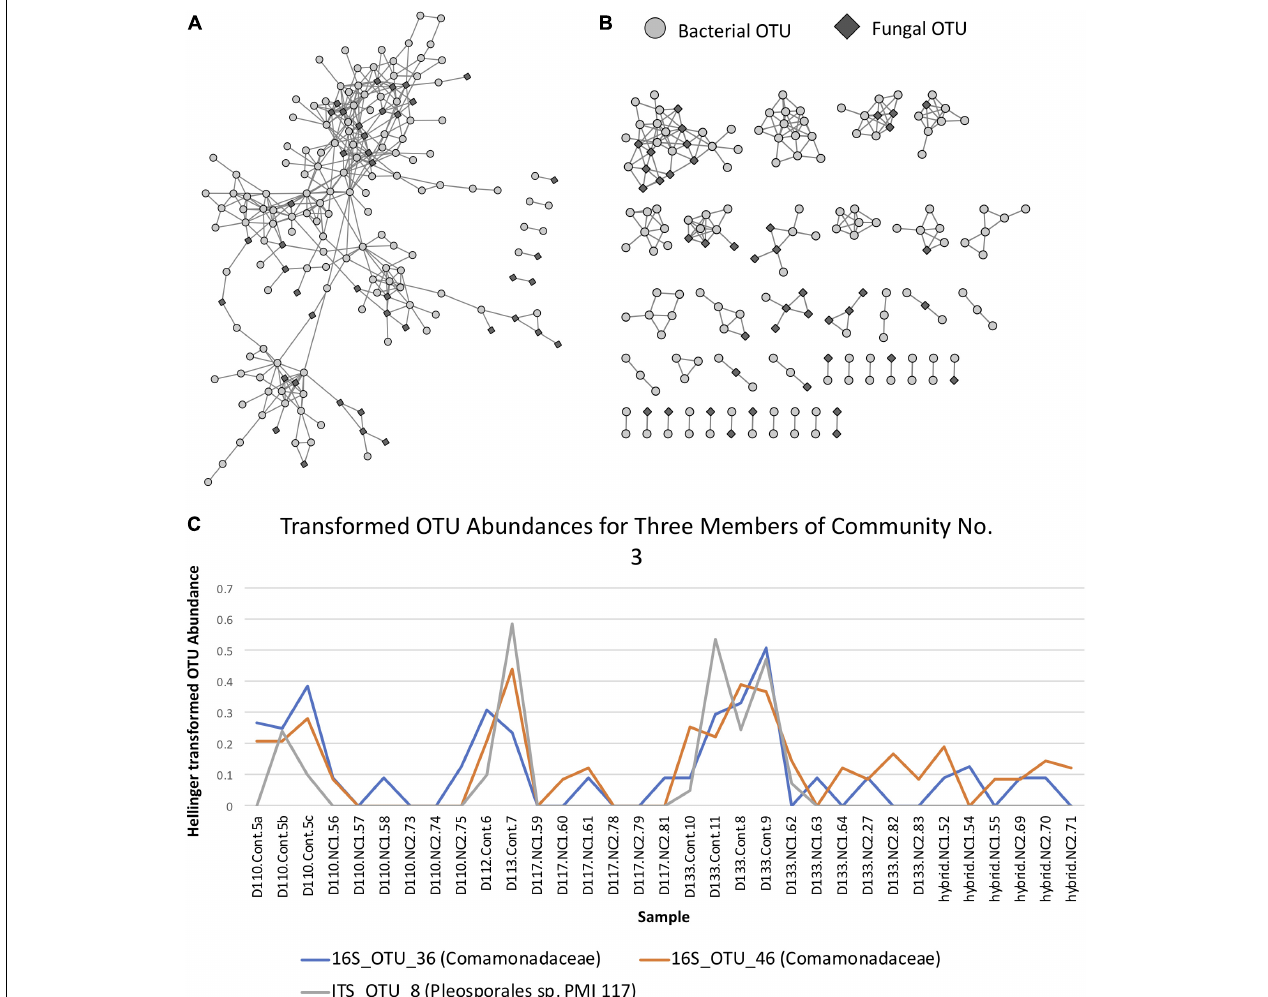
FIGURE 6 | (A) Operational taxonomic unit (OTU) Pearson correlation network for Experiment 1, indicating the correlations between OTUs across samples. (B) Markov Cluster (MCL) community clusters of OTUs constructed from clustering of the network in Figure 6A . (C) Example line plot of 3 OTUs in MCL community 3, illustrating their correlated